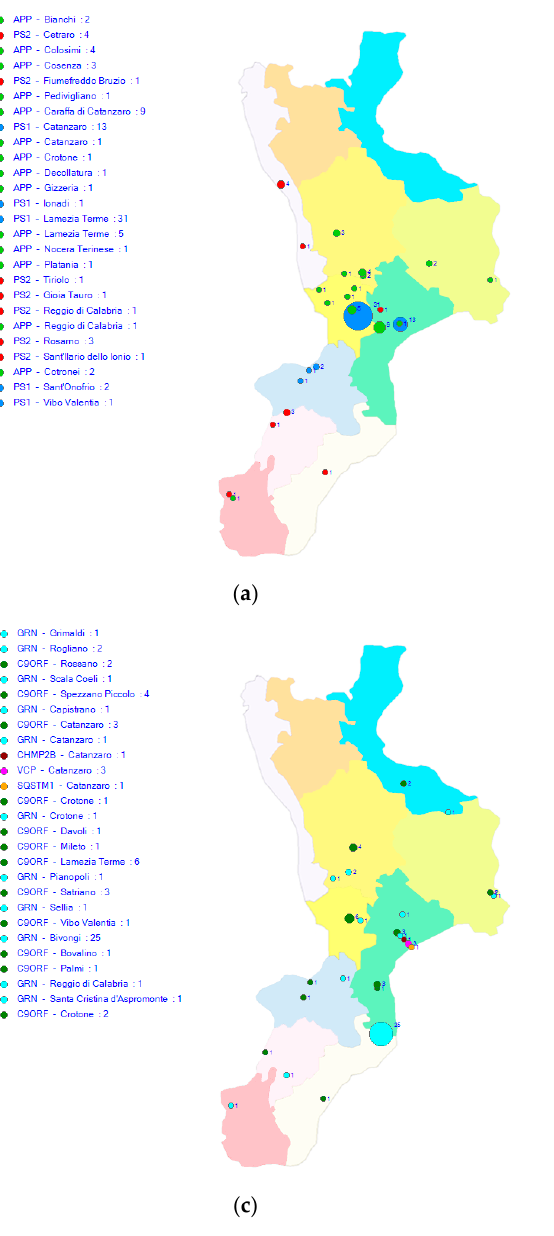
Figure 1. Geographical distribution of mutations in Calabria: ( a ) mutations associated with Alzheimer’s disease; ( b ) APOE ε 4 carriers affected by Alzheimer’s disease; ( c ) mutations associated with frontotemporal dementia and amyotrophic lateral sclerosis; ( d ) mutation associated with other neurodegenerative diseases (unpublished data).